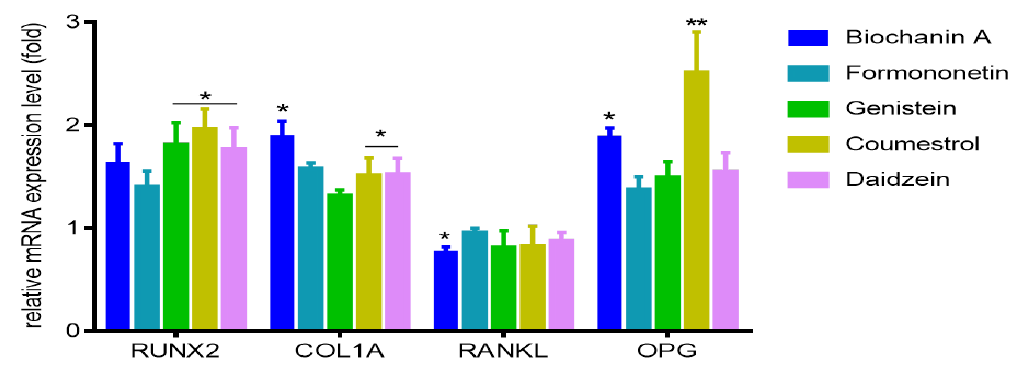
Figure 8. The influence of 14 days of exposure of isoflavones on the expression of genes in Saos-2 cells. The expression levels of RUNX2 , COL1A , RANKL , OPG were quantified by real-time PCR and normalized using glyceraldehyde-3-phosphate dehydrogenase ( GAPDH ) as a reference gene. Control cells were not exposed to any compound but the vehicle; values are means ± standard deviations, n ≥ 3; statistical significance was calculated versus control cells (untreated), * p ≥ 0.05, ** p ≥ 0.01.